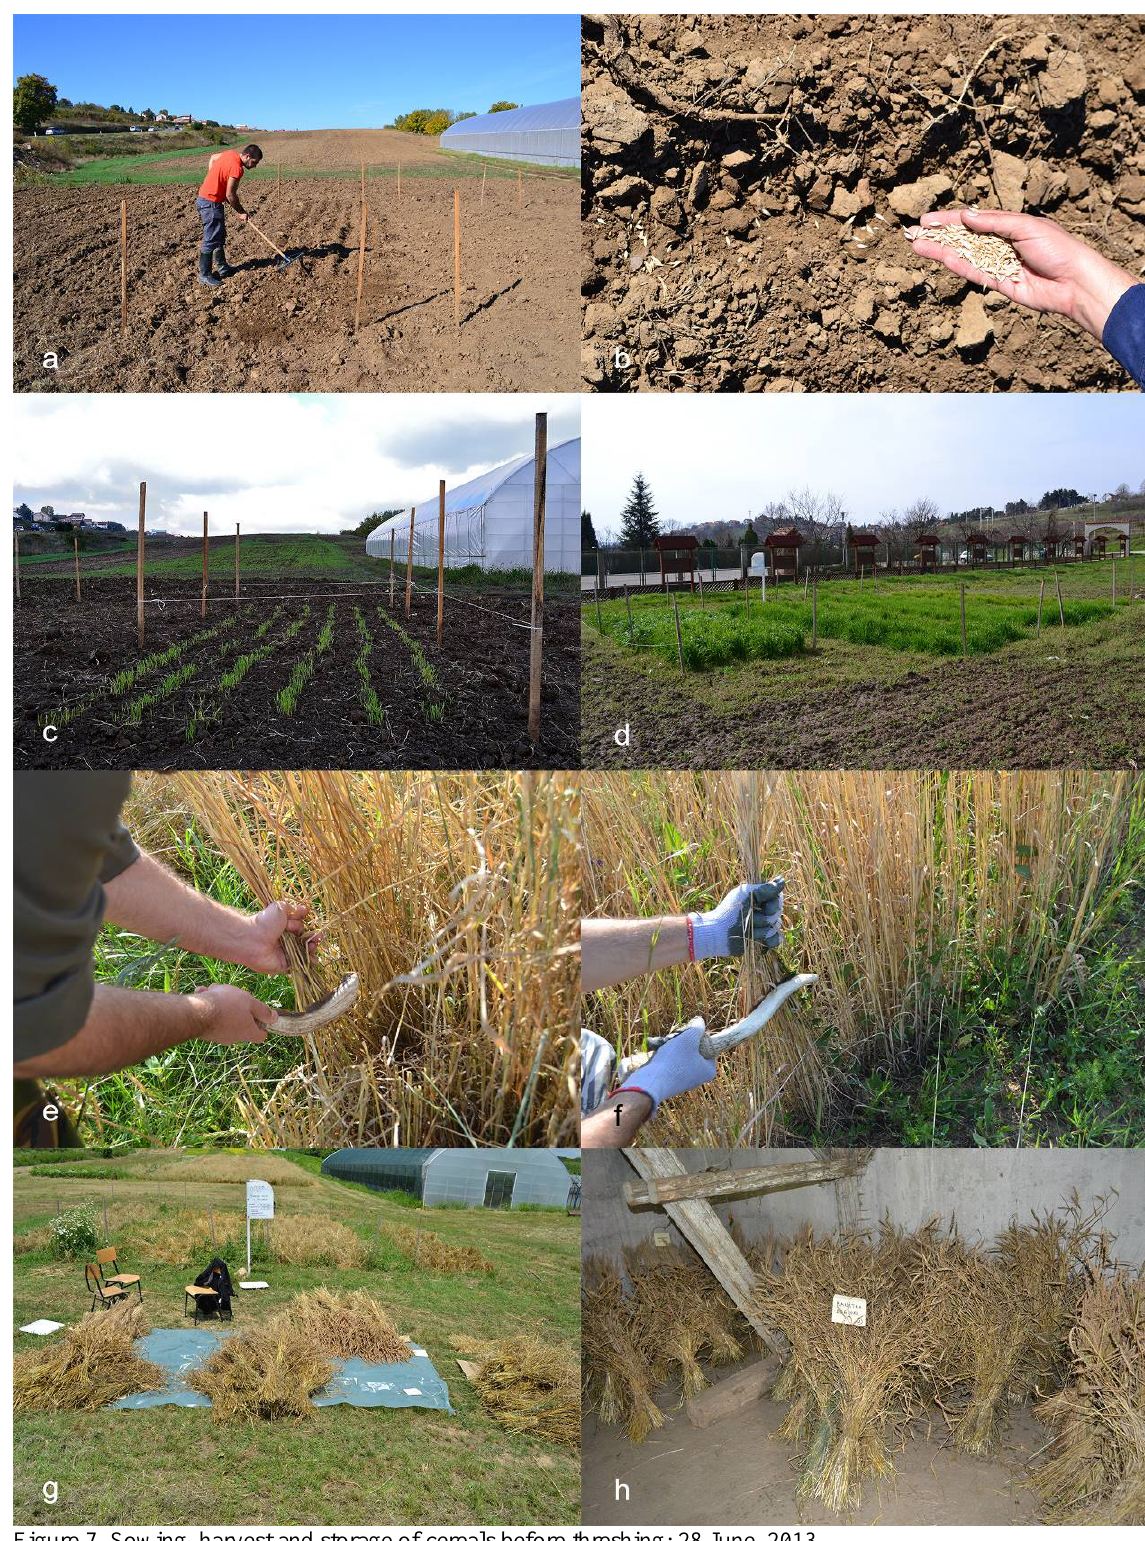
Figure 7. Sowing, harvest and storage of cereals before threshing: 28 June,